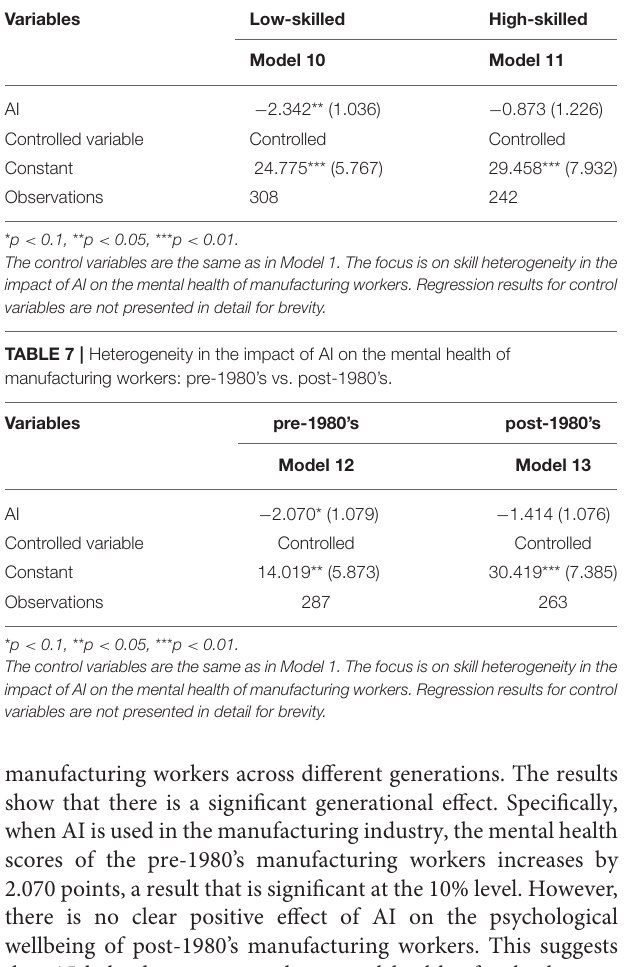
TABLE 6 | Heterogeneity in the impact of AI on the mental health of manufacturing workers: low-skilled versus high-skilled. Variables